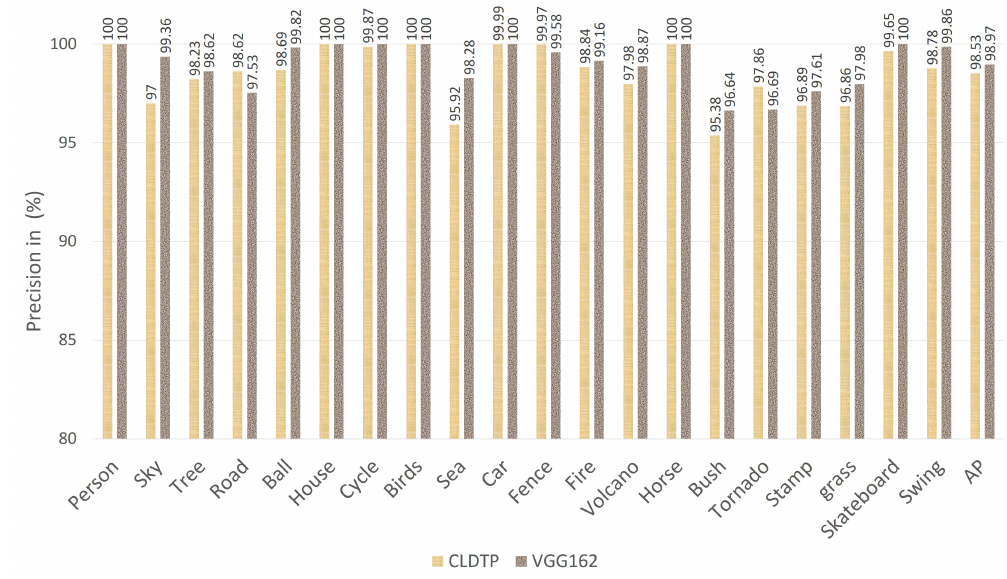
Figure 13. Precision of the CLDTP and VGGNet on